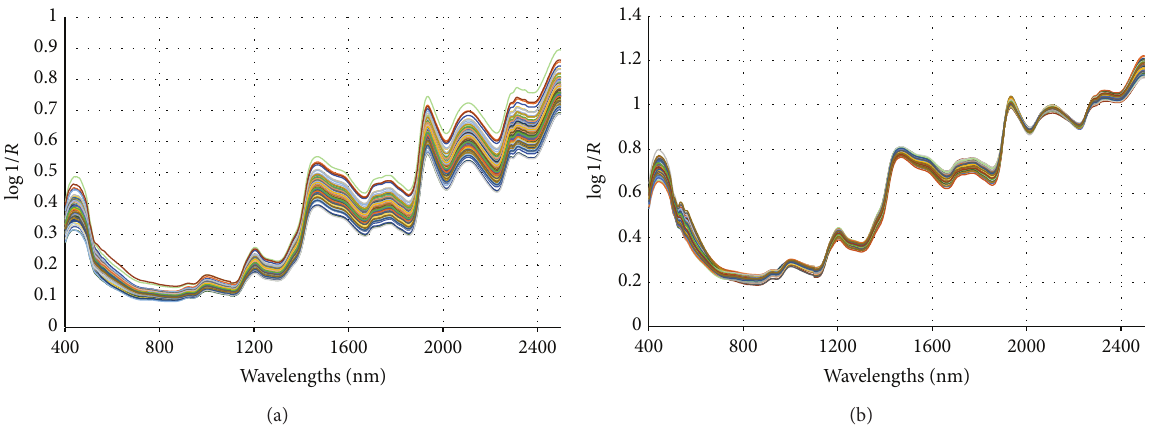
Figure 5: (a) Raw and (b) MSC infrared spectra of 117 maize samples.